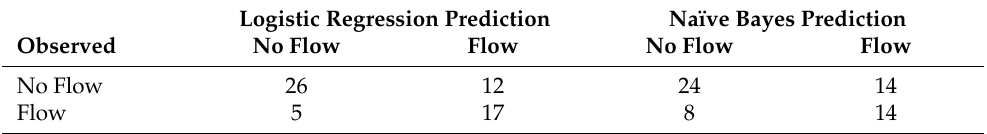
Table 4. Confusion matrices for the logistic regression and naïve Bayes algorithms using between- participant cross-validation.